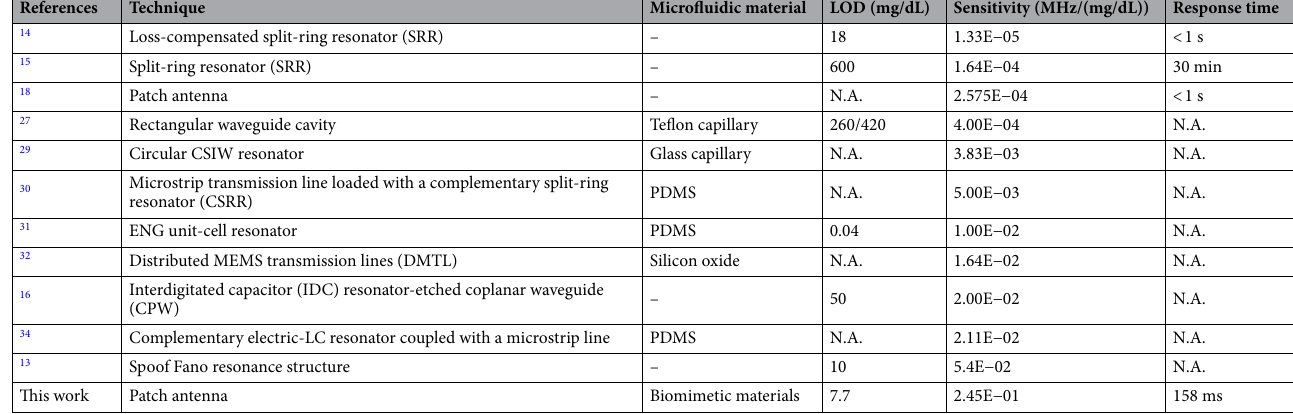
Table 3. Comparison of the proposed microfluidic sensor and other microfluidic sensors (the test results of glucose solution are used for the comparison of sensitivity). N.A. Not Available, – the sensor without a microfluidic device.